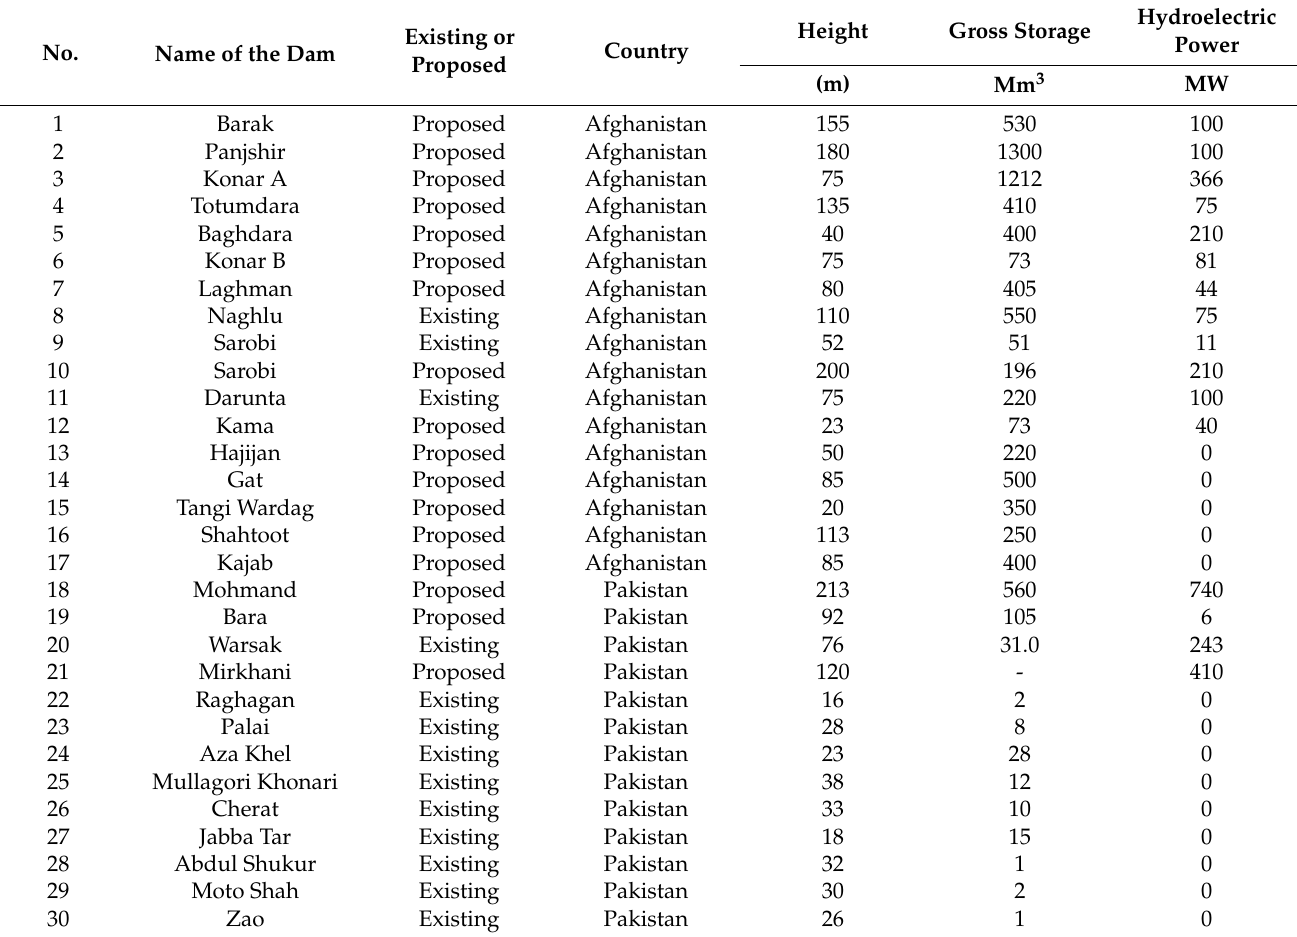
Table 1. Existing and proposed dams in the KRB (Afghanistan and